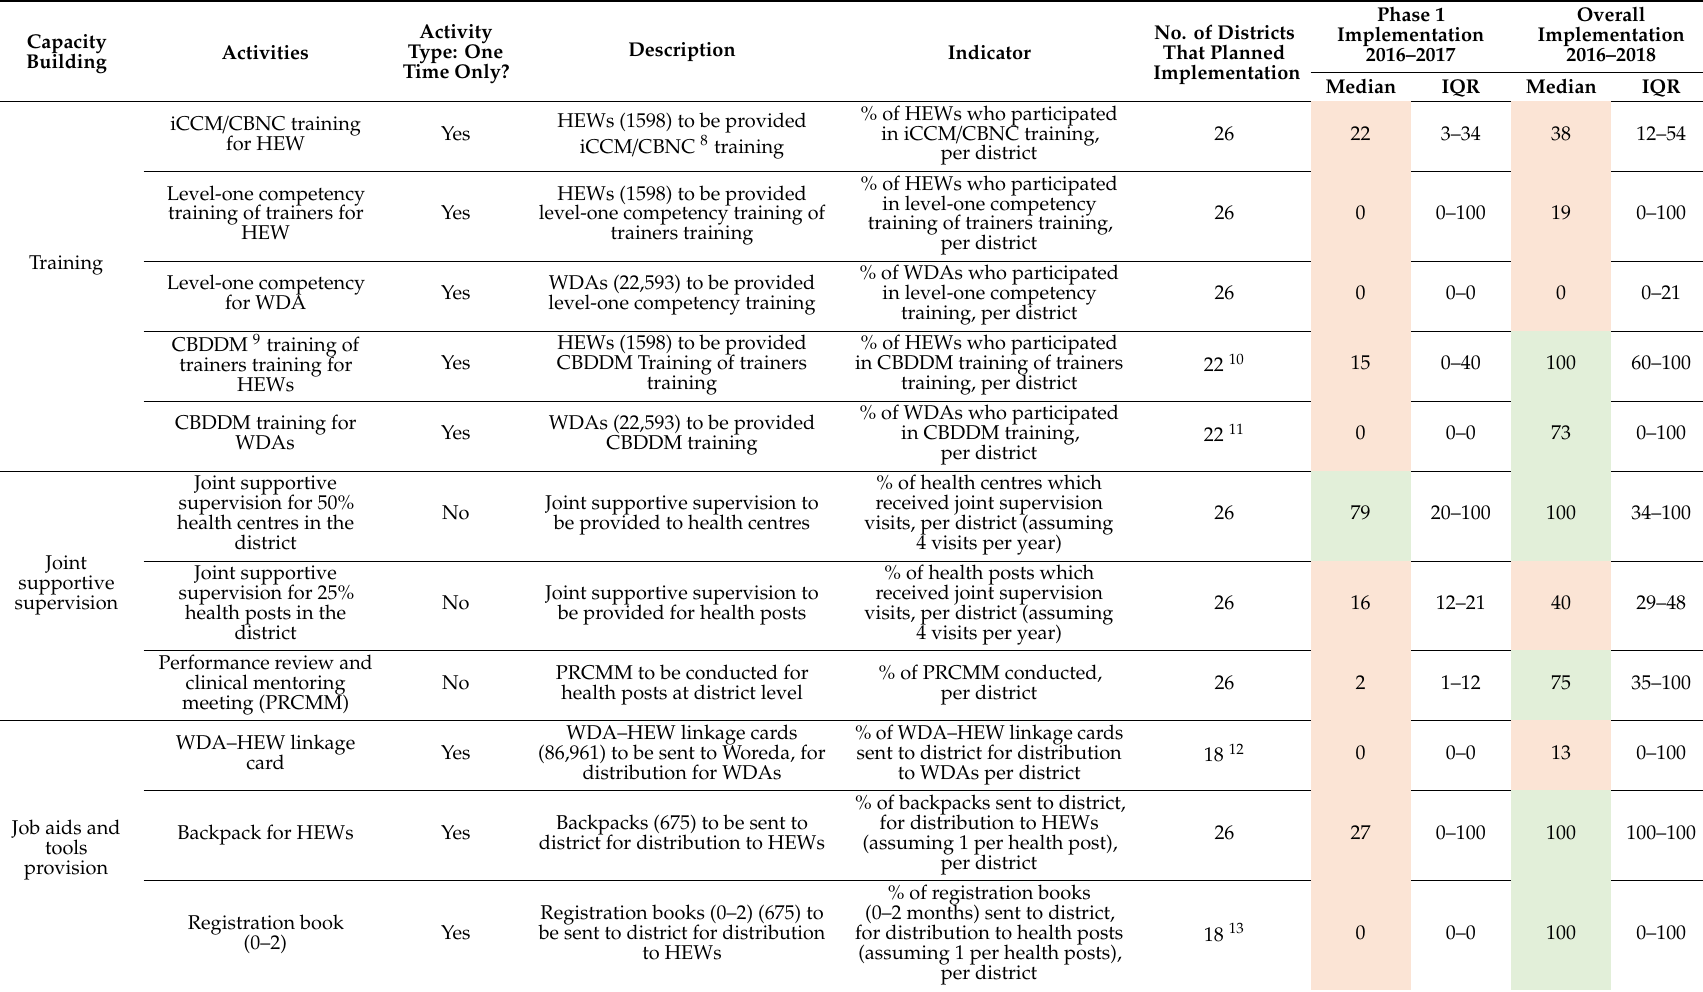
Table 2. Fidelity of implementation activities under capacity-building strategy in 26 districts categorised by implementation year (overall 2016–2018; and restricted to 2016–2017). IQR: inter-quartile range (fidelity benchmark: > 70% pale green, 50–69% pale yellow, and < 50% pale